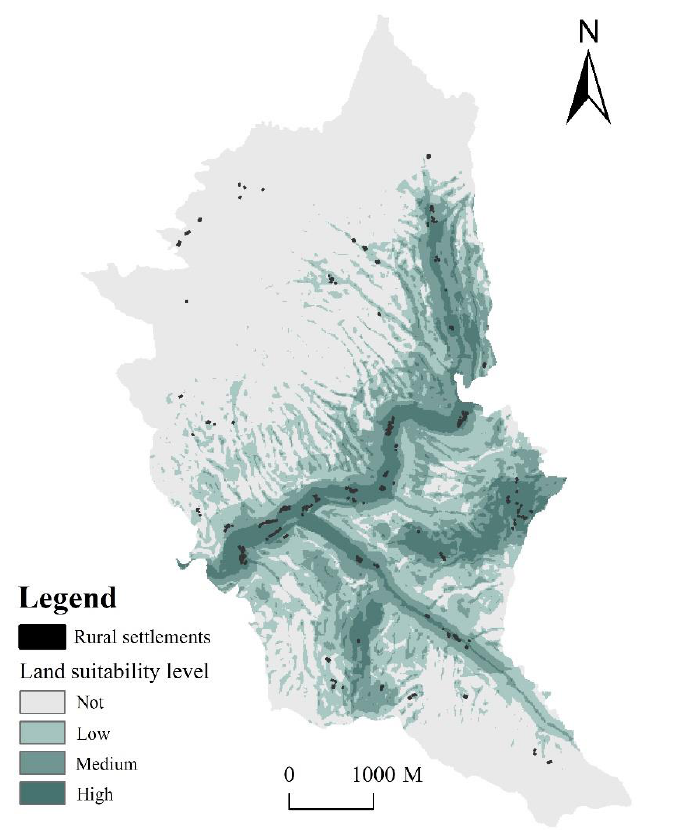
Figure 3. Suitability map of rural settlement layout. Table 5. Spatial differentiation of rural settlements according to land suitability.